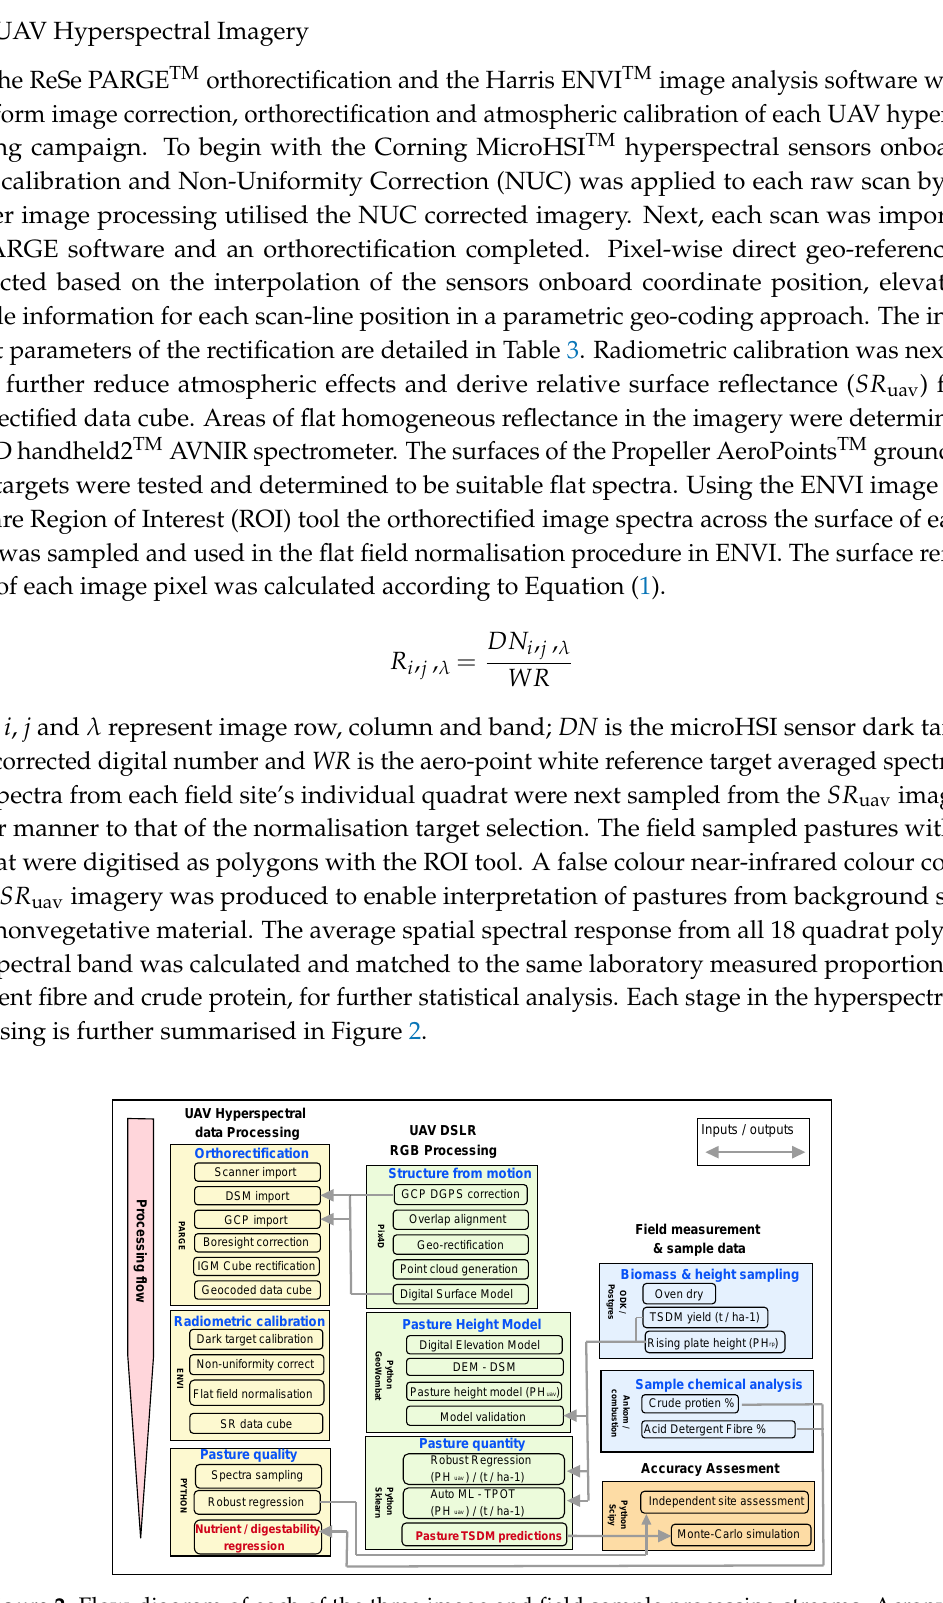
Figure 2. Flow-diagram of each of the three image and field sample processing streams. Acronyms: DSM—Digital Surface Model, GCP—Ground Control Point, IGM—Input Geometry Method, SR—Surface Reflectance, Auto ML—Automatic Machine Learning, DSLR—Digital Single-lens